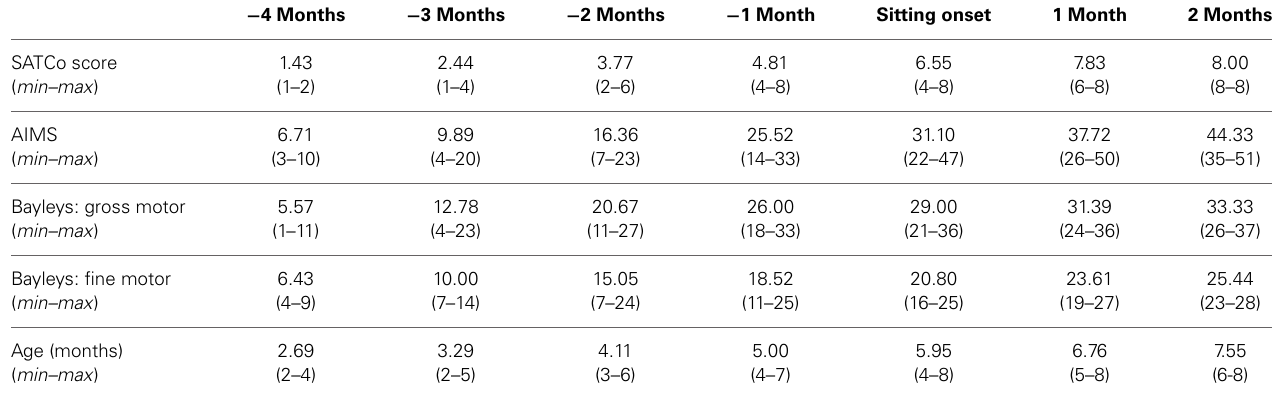
Table 1 | Clinical scores across